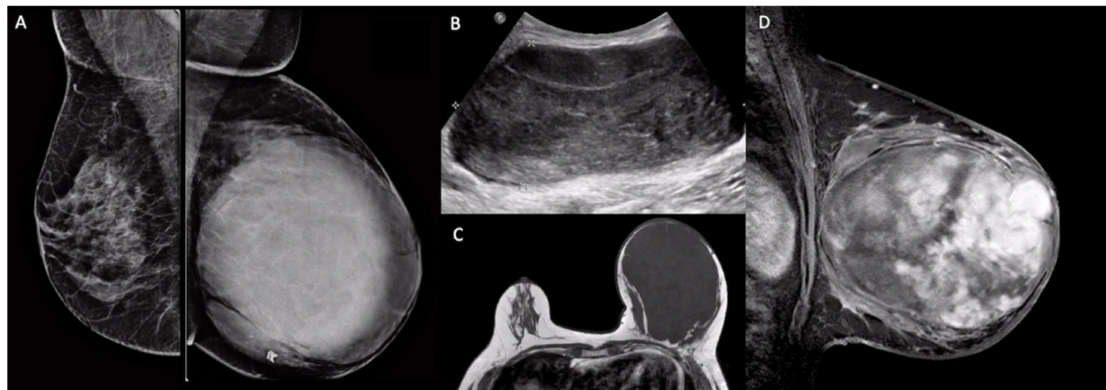
Figure 3. Imaging findings of a malignant phyllodes tumor. ( A ): Bilateral mammography (mediolateral oblique view) showed a large, round, circumscribed, high-density mass in the left breast. ( B ): Breast ultrasound showed an oval, parallel, circumscribed mass with a heterogeneous echo pattern. ( C ): T1-weighted axial magnetic resonance imaging (MRI) showed a large, hypointense, circumscribed mass in the left breast. ( D ): T1-weighted sagittal fat-saturated contrast-enhanced MRI showed heterogeneous internal enhancement within the